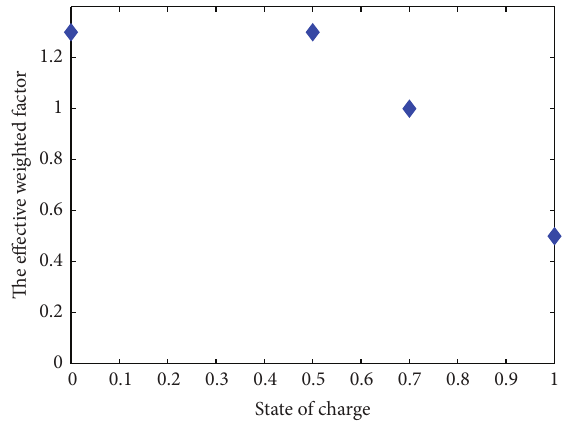
Figure 3: The relationship between EWF and SOC of lead-acid